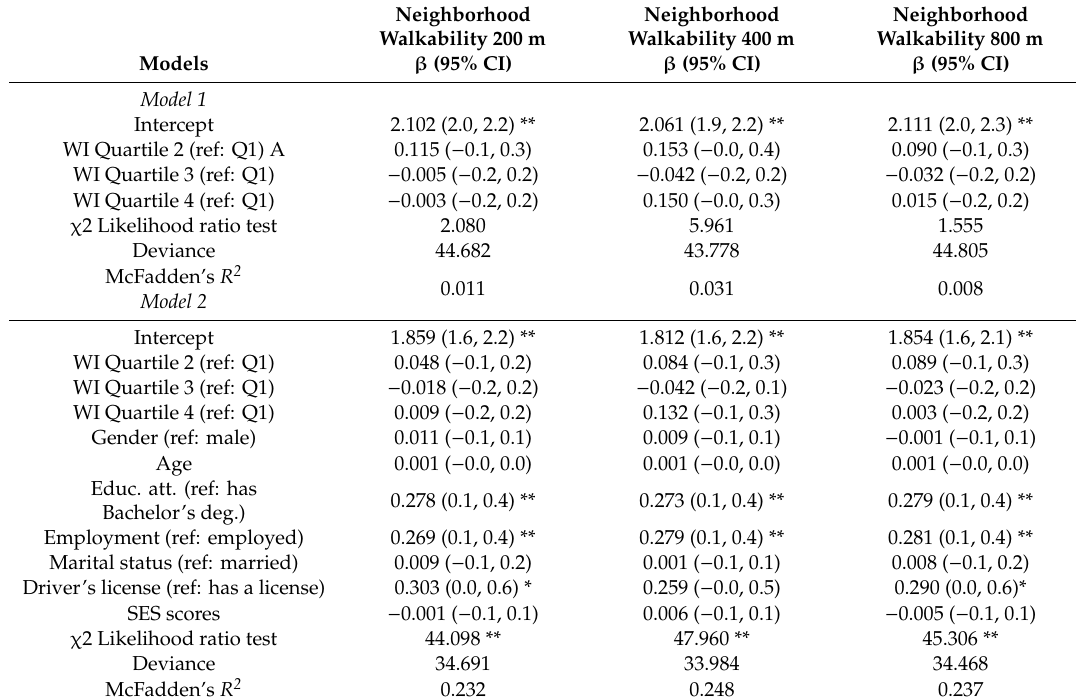
Table 6. Results of the gamma GLM for total sedentary